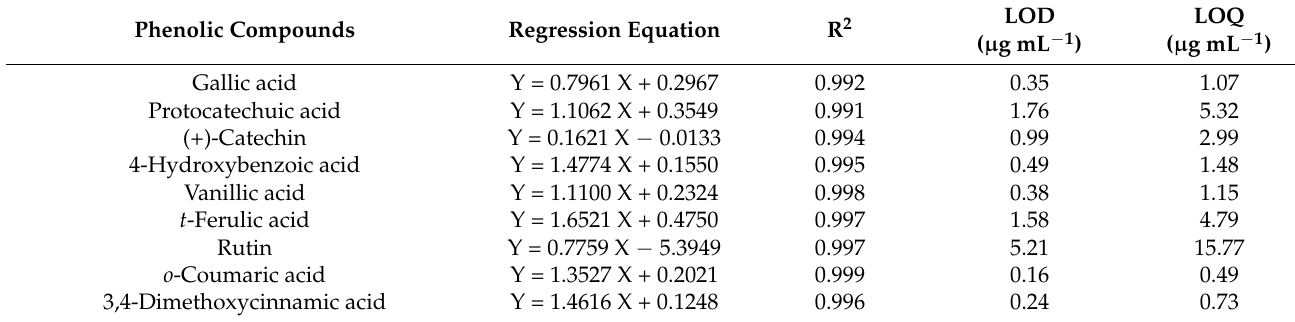
Table 7. Chromatographic parameters of phenolic compounds analysed by HPLC. Phenolic Compounds Regression